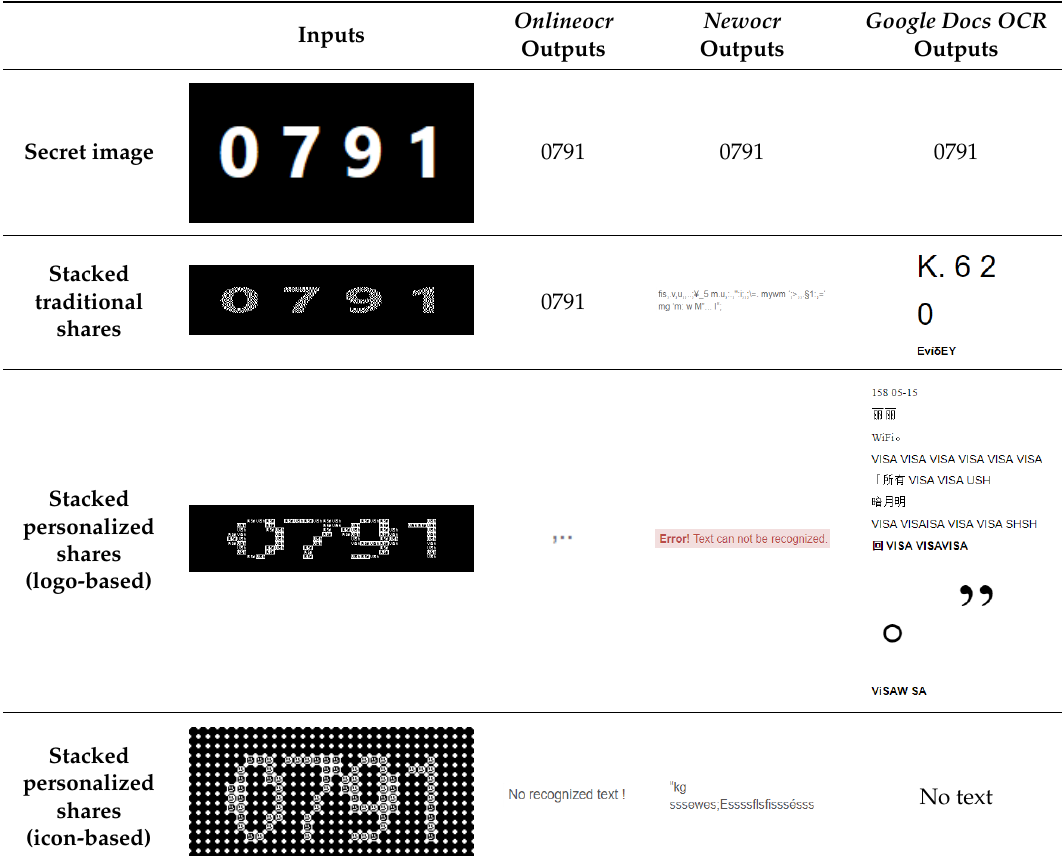
Table 1. Evaluation of robustness to the decoding of information from a secret image and from superposed traditional and personalized shares. Comparisons are done by using well-known Optical Character Recognition (OCR) systems. Inputs have only been rescaled to the same size for presentation of the